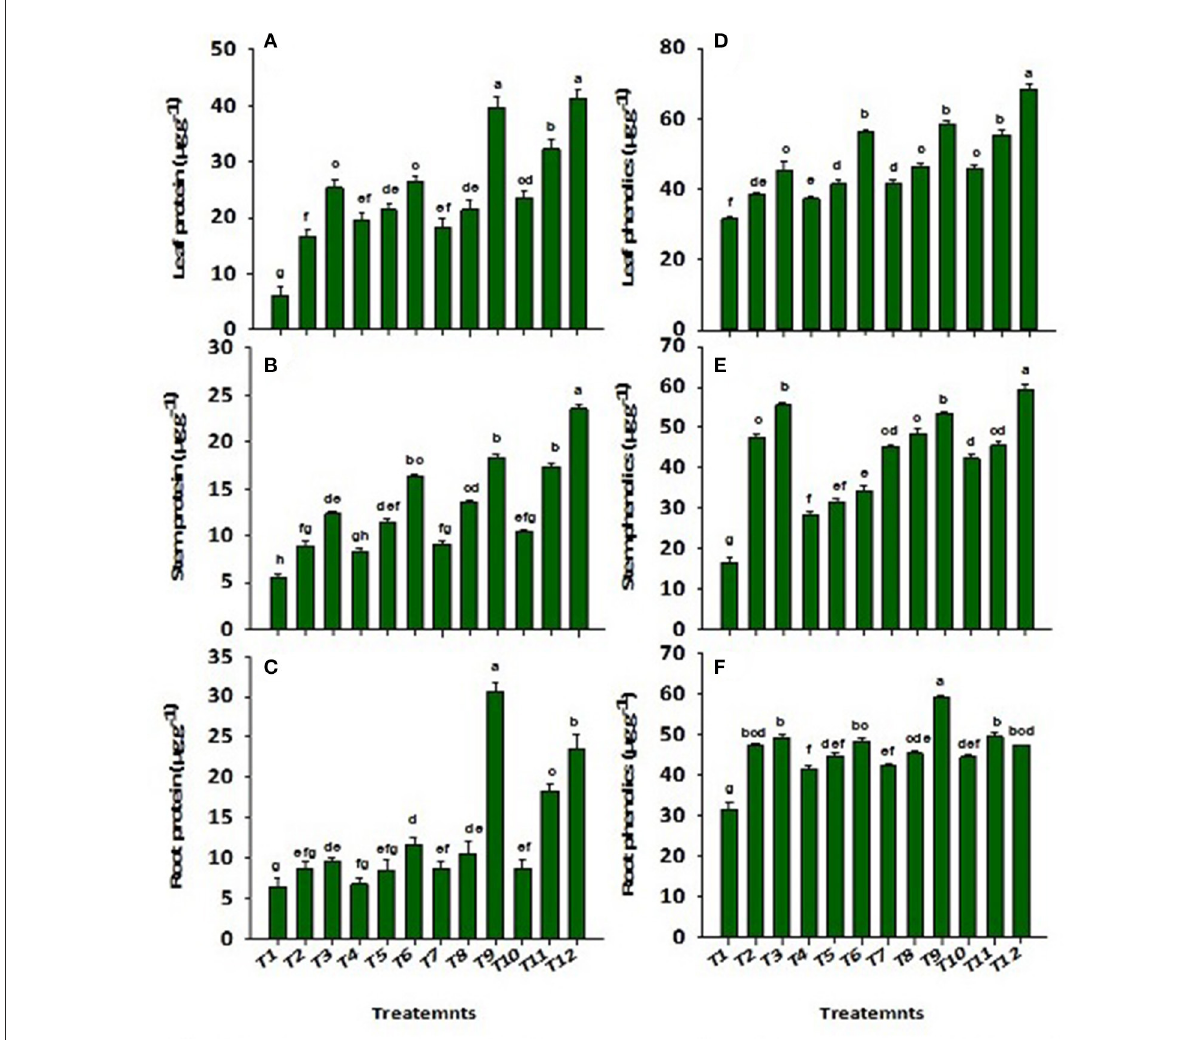
FIGURE4 Concentration of proteins in (A) leaf, (B) stem, (C) root and phenolics in (D) leaf, (E) stem and (F) root of Solanum melongena L. plant grown in heavy metal contaminated soil (waste water applied as stress) under different treatments such as T1 = Control; T2 = CP-Silica gel; T3 = ZnBc; T4 = B1; T5 = B2; T6 = B3; T7 = CP-Silica gel + B1; T8 = CP-Silica gel + B2; T9 = CP-Silica gel + B3; T10 = ZnBc + B1; T11 = ZnBc + B2 and T12 = ZnBc + B3. Values are the average of three replicates ± standard error (SE). Mean bars sharing similar lower case alphabetic letters